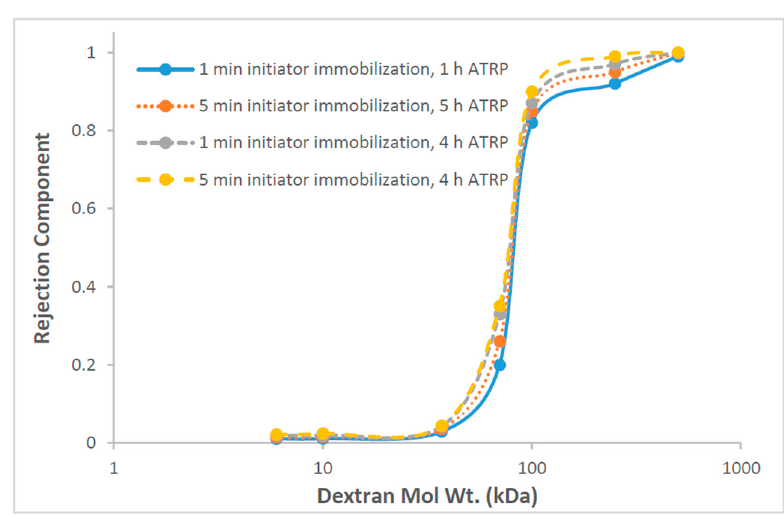
Figure 5. Dextran rejection as function of molecular weight for membranes modified under different conditions.